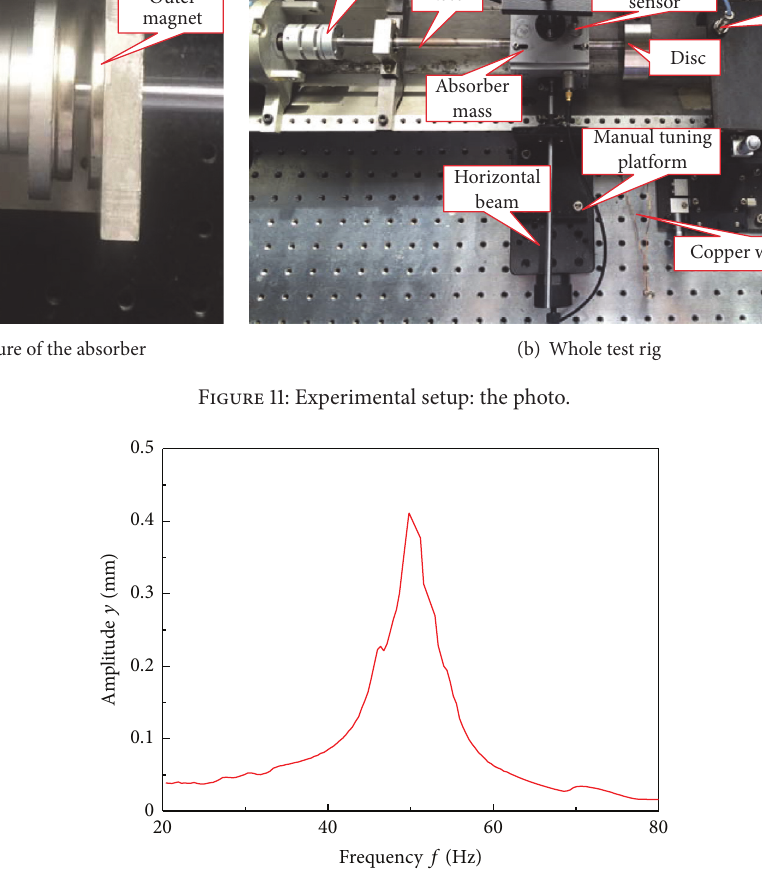
Figure 12: Response of the rotor system without the